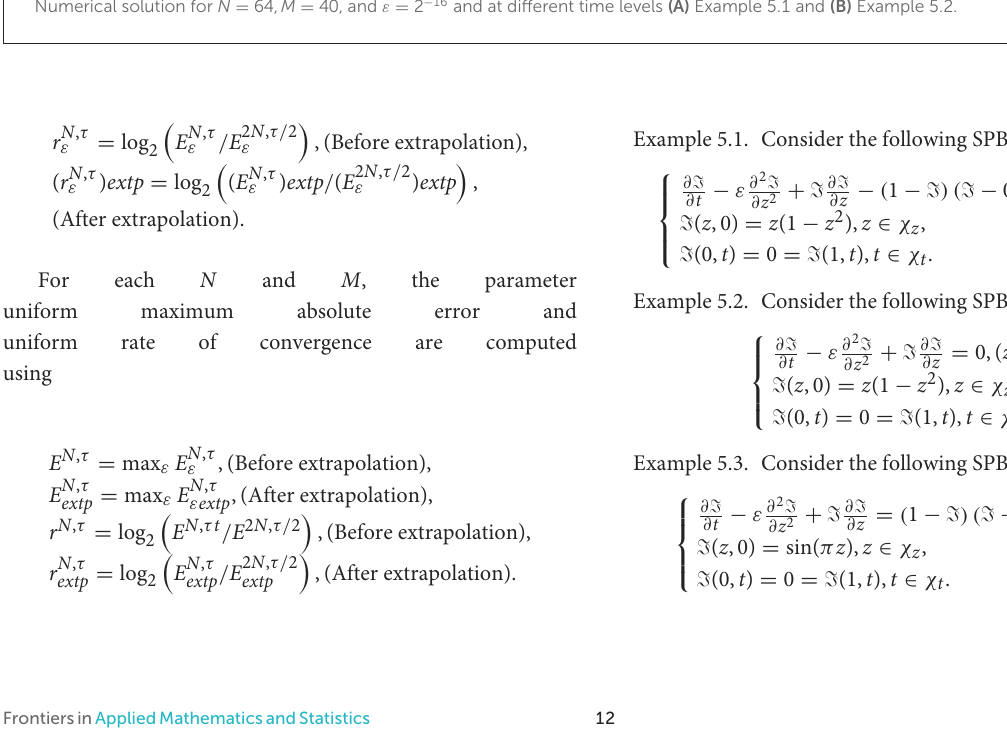
FIGURE3 Numerical solution for N = 64, M = 40, and ε = 2 − 16 and at different time levels (A) Example 5.1 and (B) Example